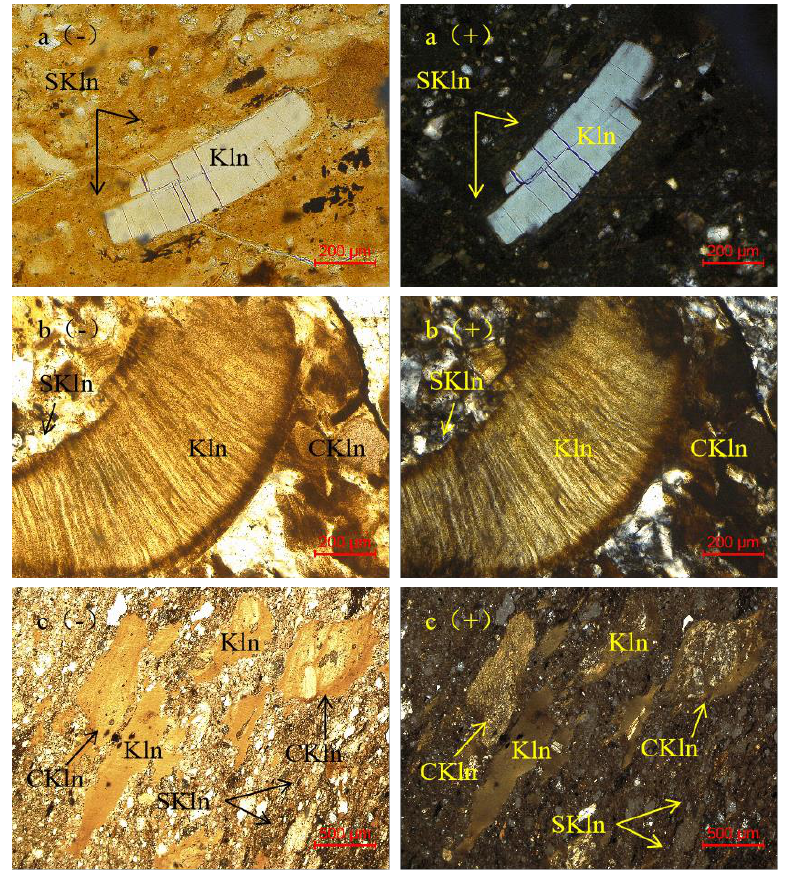
Figure 3. The plane-polarized light microscopy (Leica 2700) images of kaolinite rock samples under single polarization ( − ) and cross-polarization (+), where panels ( a ) kaolinite rock represent sample S4F, including scaly and flaky texture kaolinite; panels ( b ) represent sample C2F, including scaly, clastic and vermicular texture kaolinite; and panels ( c ) represent sample C3R, including scaly, clastic and flaky texture kaolinite. Kln, kaolinite; Qz, quartz; SKln, scaly kaolinite; CKln, clastic kaolinite.